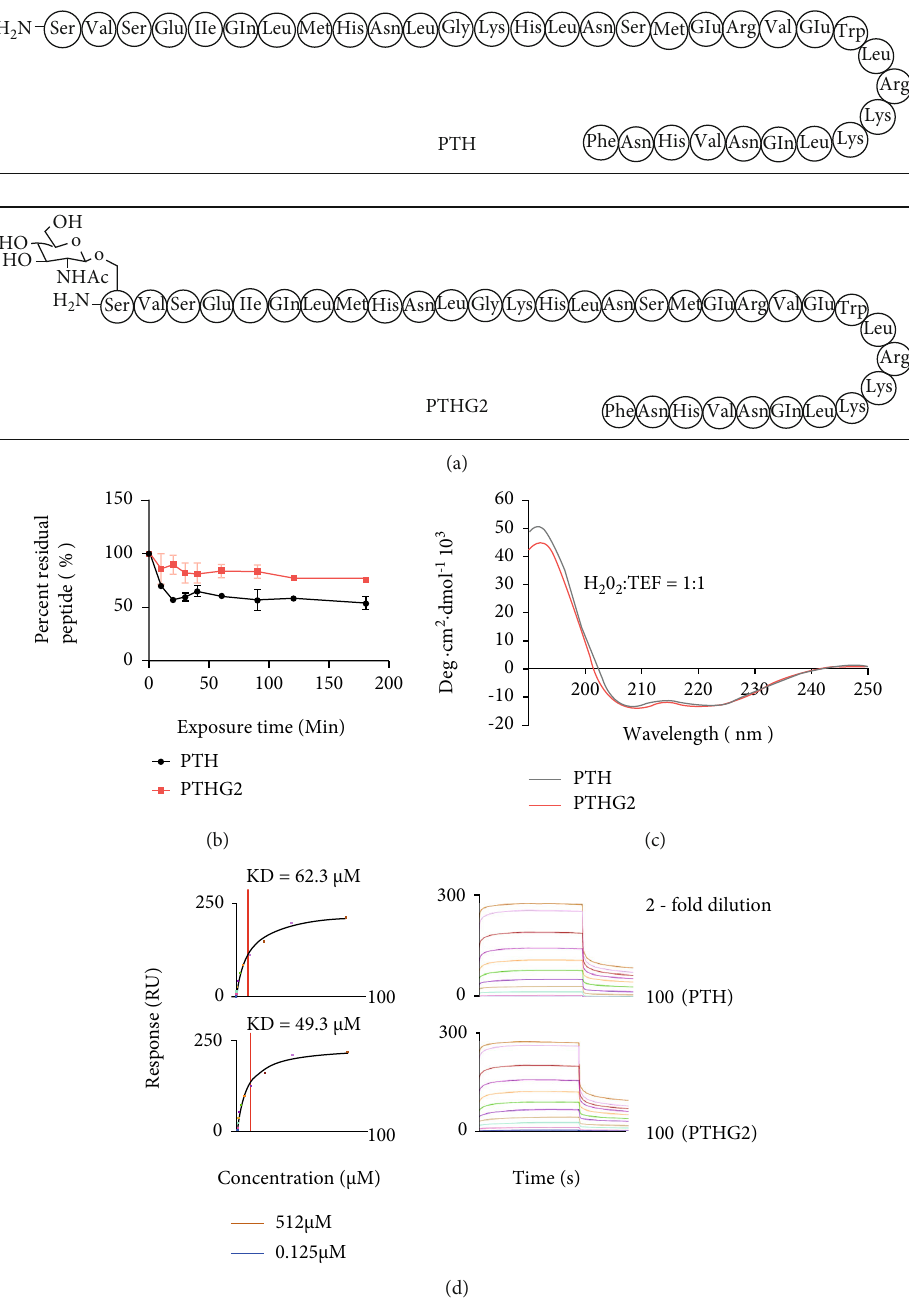
Figure 1: The stability of PTHG2 is better than that of PTH (1-34). (a) The structural formula of PTHG2; (b) the resistance of PTH (1-34) and PTHG2 to proteolytic cleavage was measured; (c) CD spectra of PTHG2 in 50.0% TFE water solution at 20 ° C; (d) the a ffi nity between PTHG2 and PTHR1. Data appeared as mean ± standard deviation ( n = 3